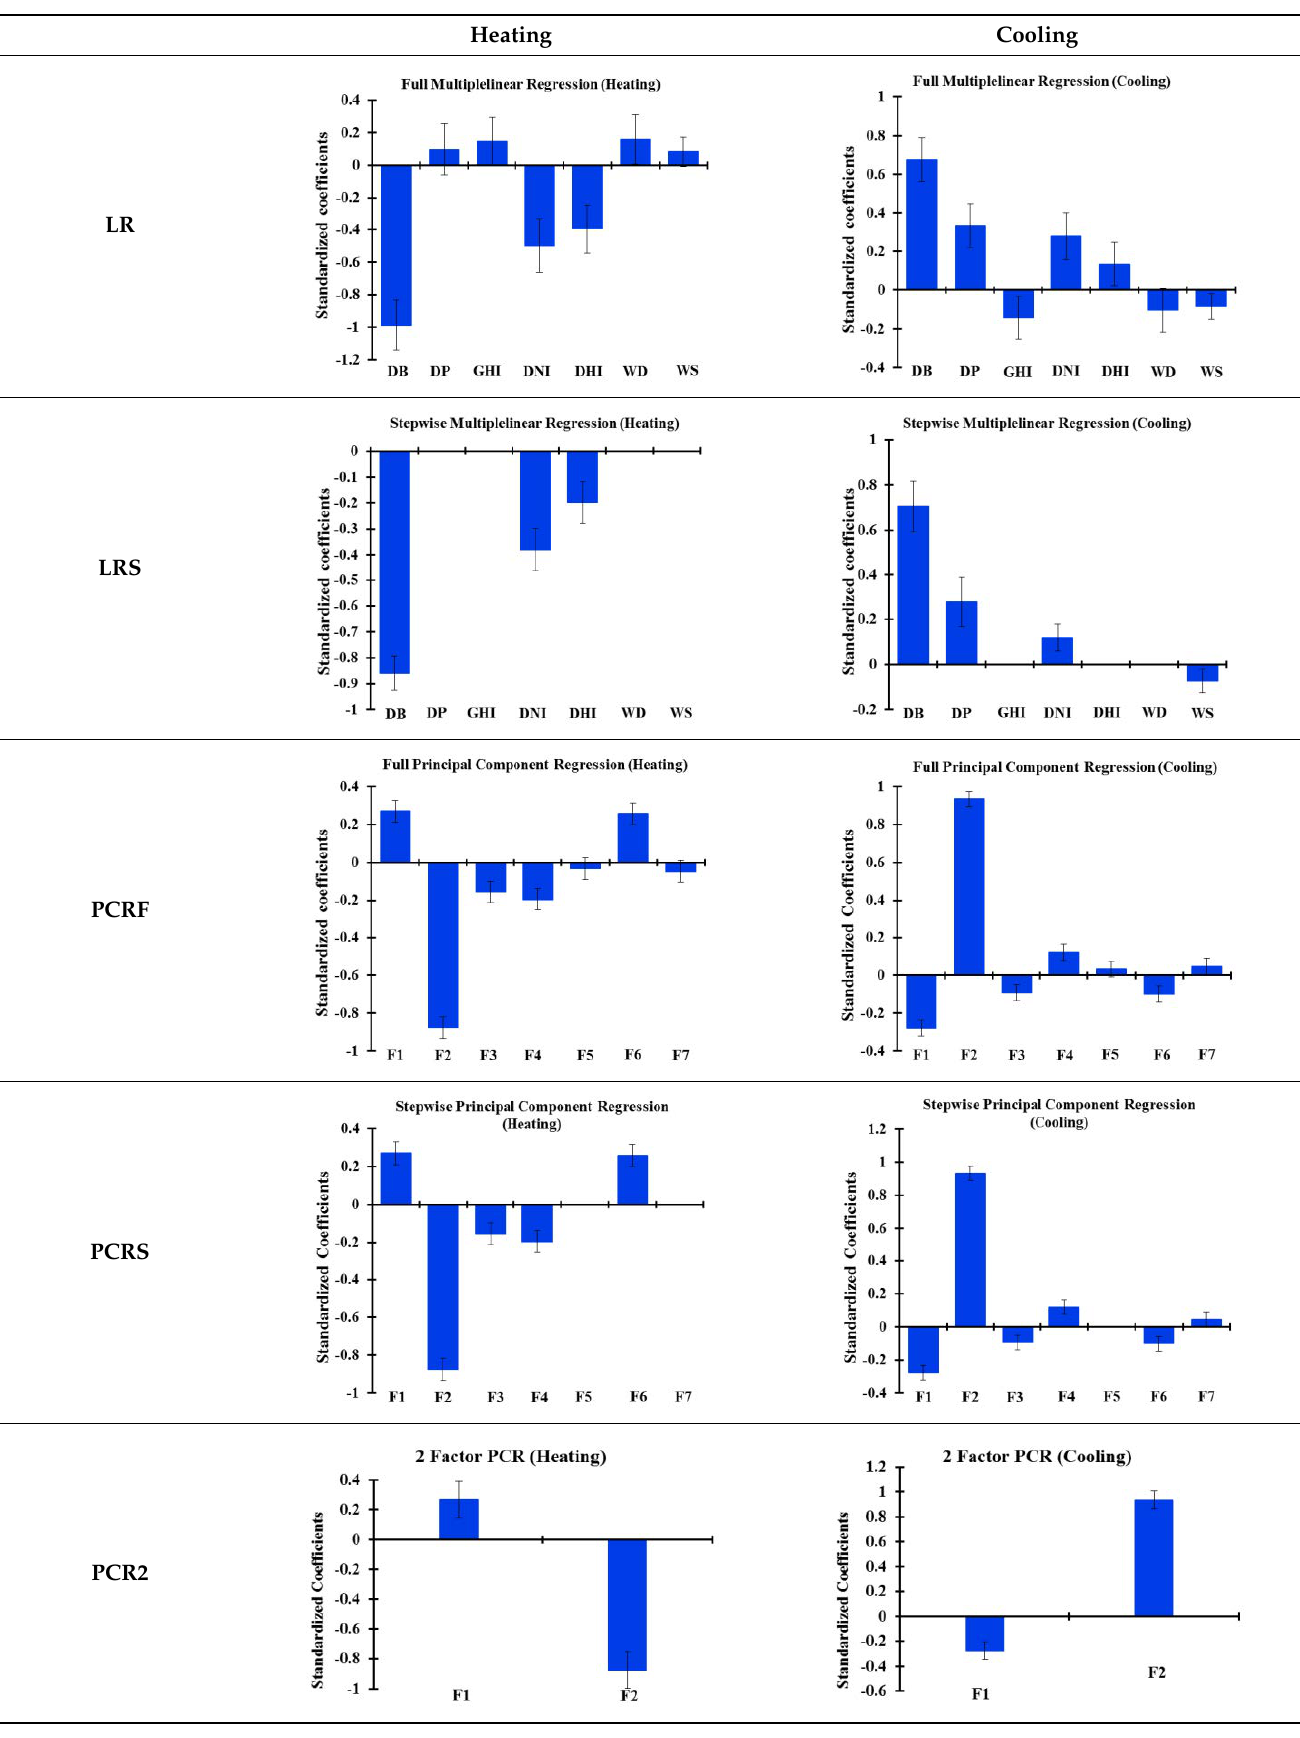
Table A4. Details of the regression models standardized